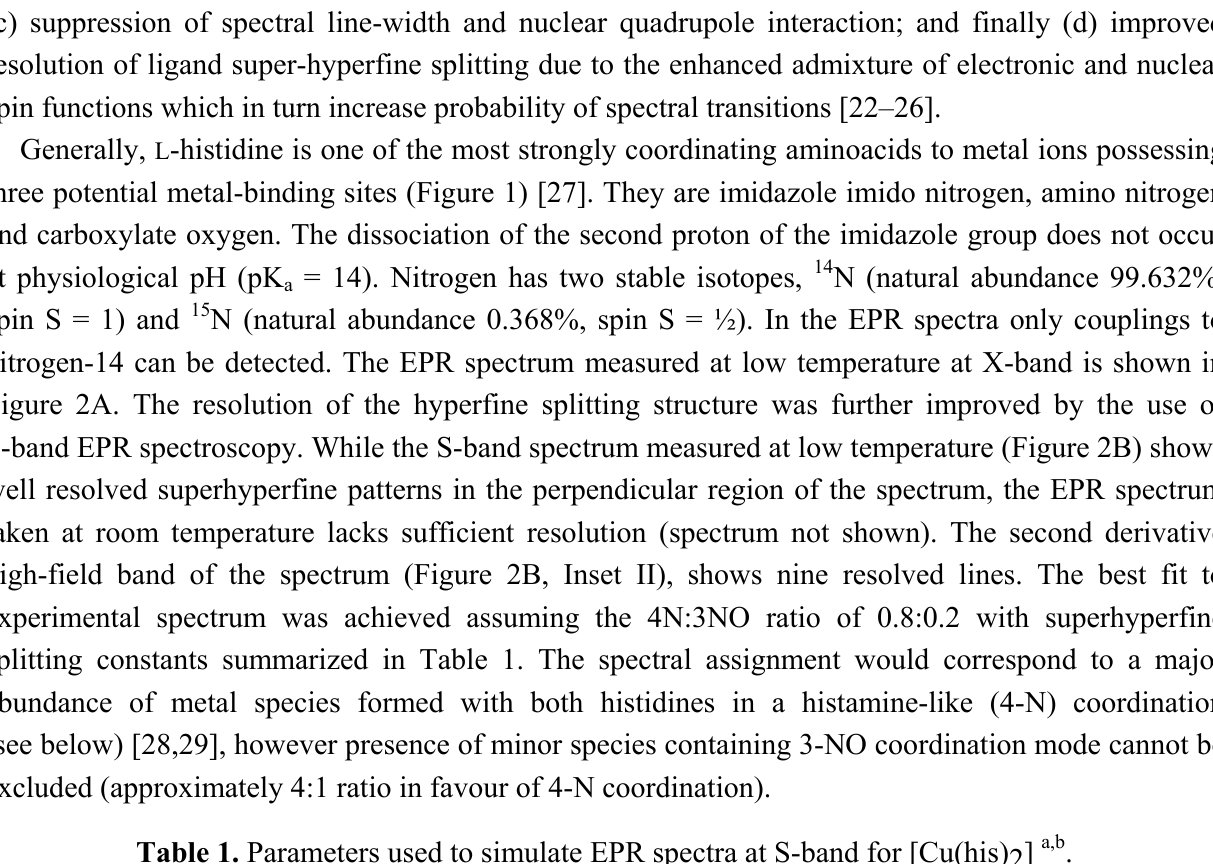
Table 1. Parameters used to simulate EPR spectra at S-band for [Cu(his)2] a,b .